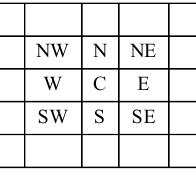
Fig. 8. Moore neighborhood as the 8 cells around a central cell.